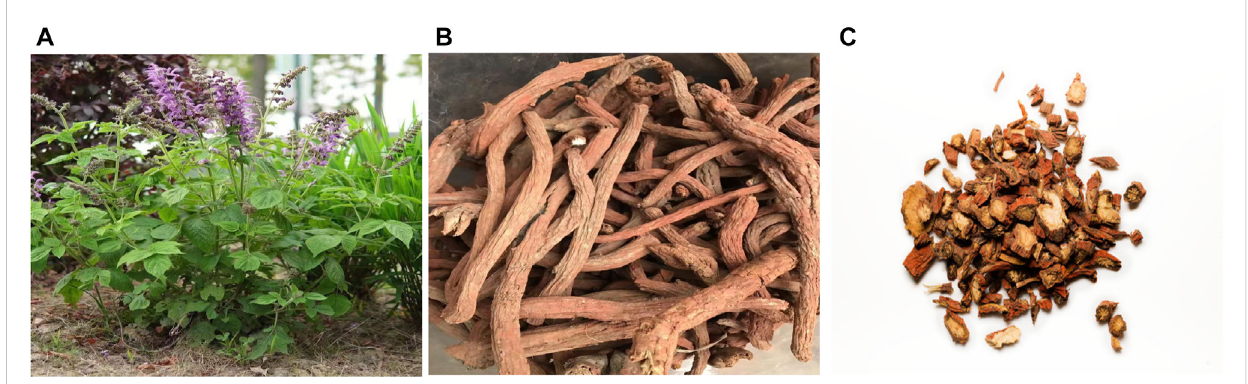
FIGURE 1 (A) The above-ground portion of salvia miltiorrhiza ; (B) The rhizome of salvia miltiorrhiza ; (C) commercial herbal pieces of salvia miltiorrhiza